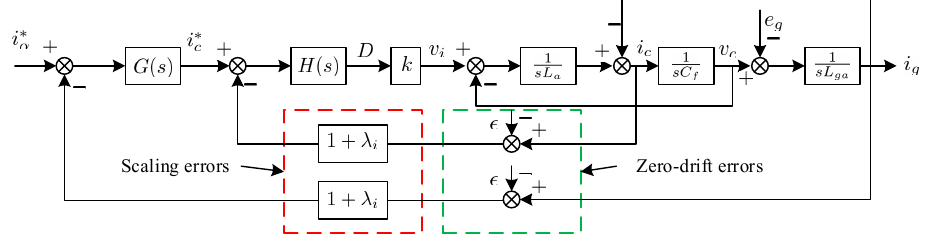
Figure 2. Closed-loop control diagram of LCL-type grid-connected inverter considering zero-drift and scaling error.